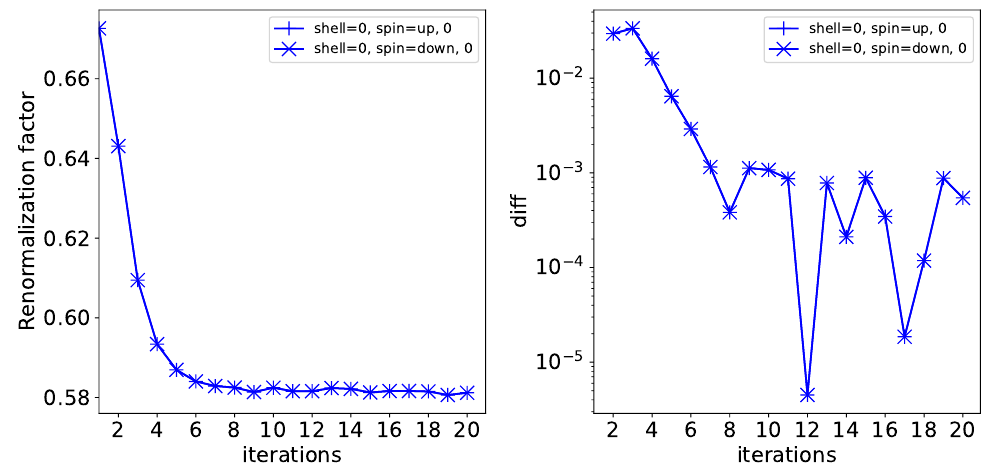
Figure 9: Case of CT-HYB solver for a figure generated by dcore_check for a con- vergence check. See the caption in Fig.